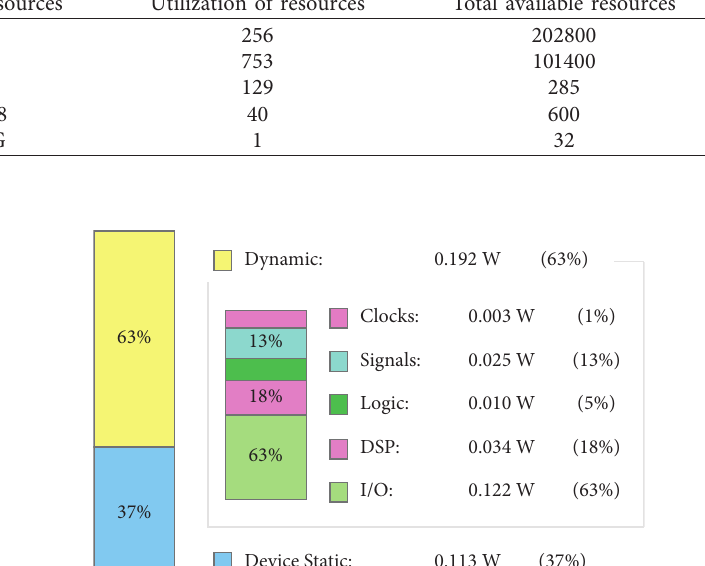
Table 1: Resource utilization table for the 4D PWL hyperjerk system implemented in FPGA. S. no.